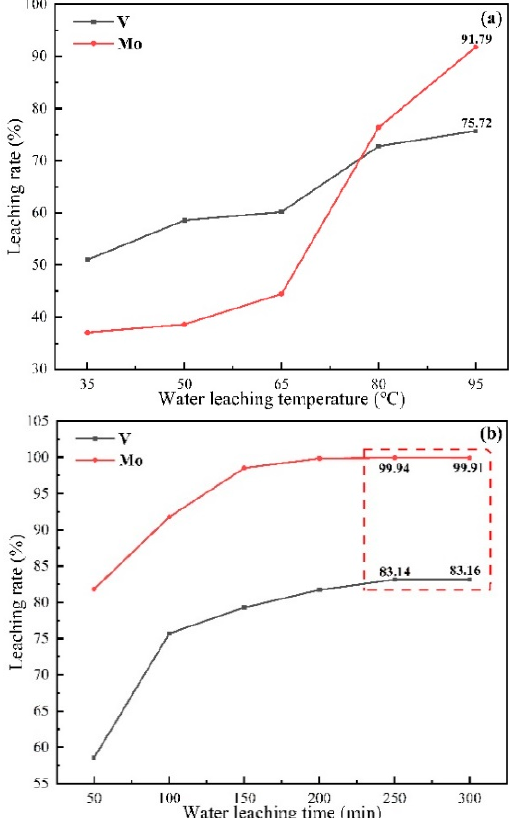
Figure 9. Effects of the water leaching temperature ( a ) and leaching time ( b ) on the leaching behaviors of V and Mo.